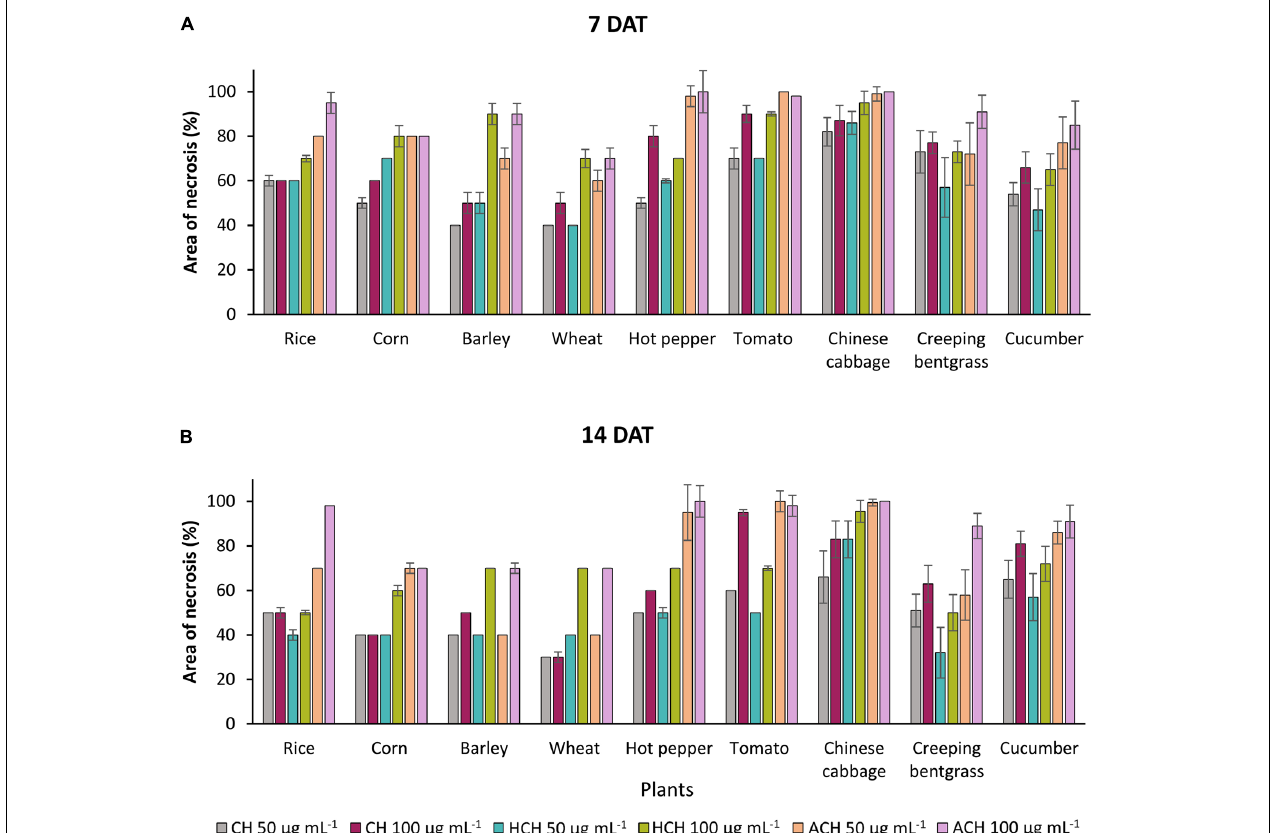
FIGURE 2 | Phytotoxic effects of CHs and its derivatives on crops in the post-emergence application at 7 in panel (A) and 14 days in panel (B) after treatment under greenhouse condition. Plants were sprayed with CHs (50 or 100 µ g mL − 1 ). CH, cycloheximide; HCH, hydroxycycloheximide; ACH, acetoxycycloheximide. Each value represents the mean ± standard deviation of two runs with three replicates per